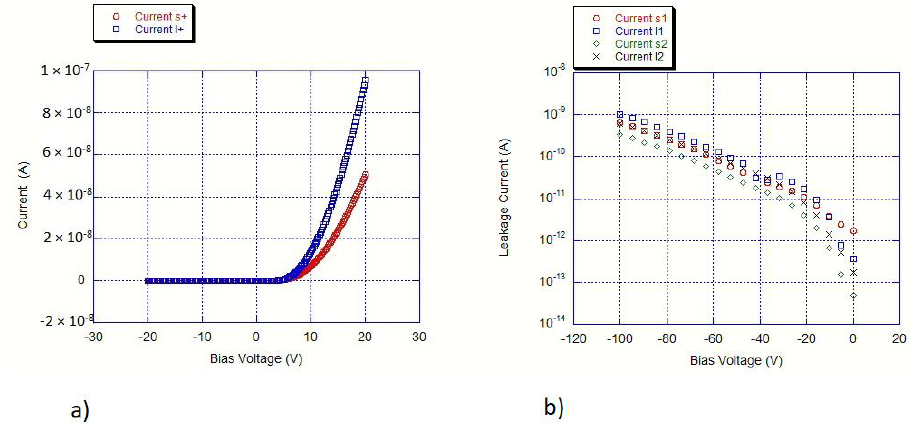
Figure 8. Leakage current vs. bias voltage in lateral detectors: ( a ) direct and reverse biasing, ( b ) reverse bias only.